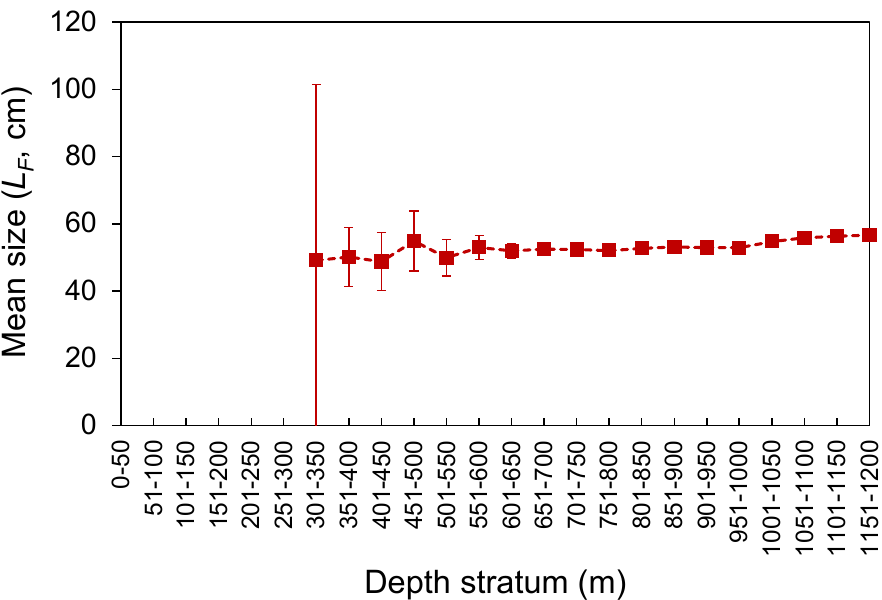
Figure 4. Mean (±0.95 confidence interval) fork length ( L F ) by depth stratum of Mora moro derived from the surveys (1996–2019) in the Azores.